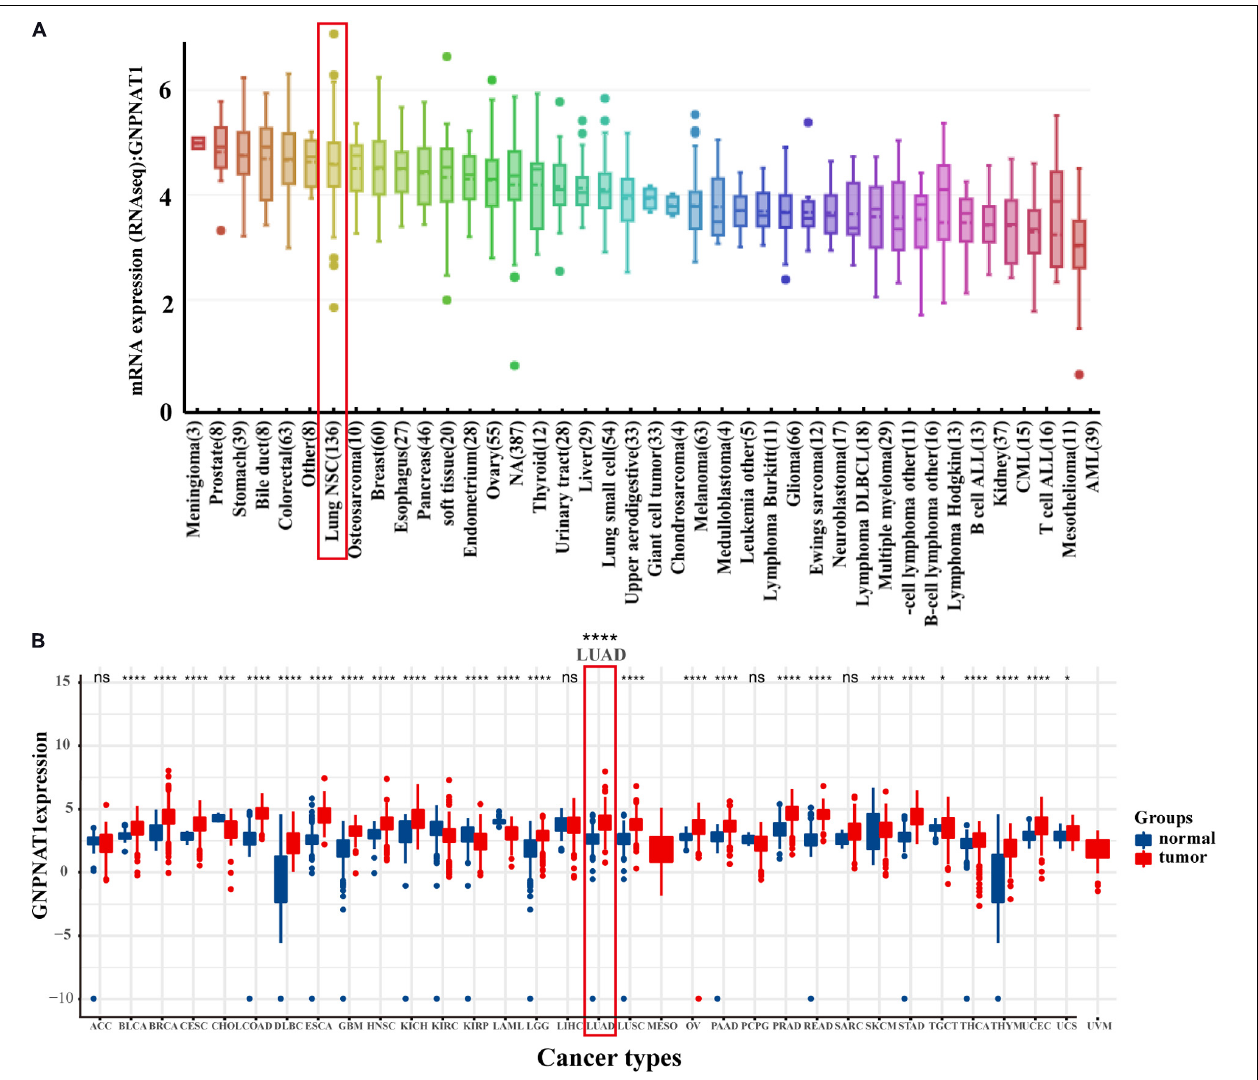
FIGURE 1 | The expression of GNPNAT1 in cancers. (A) The mRNA expression level of GNPNAT1 in cancer cells. (B) The expression level of GNPNAT1 in different tumor and normal tissues.